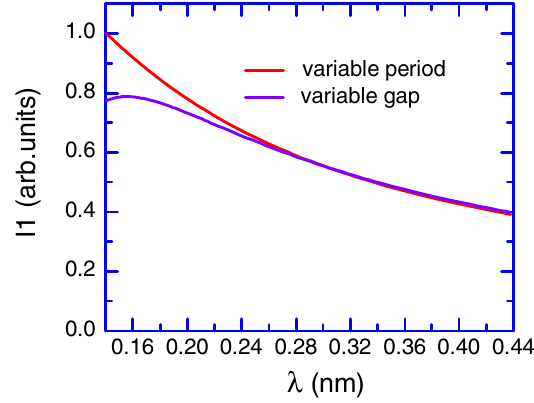
FIG. 7. The spectral intensities of the fundamental harmonics.